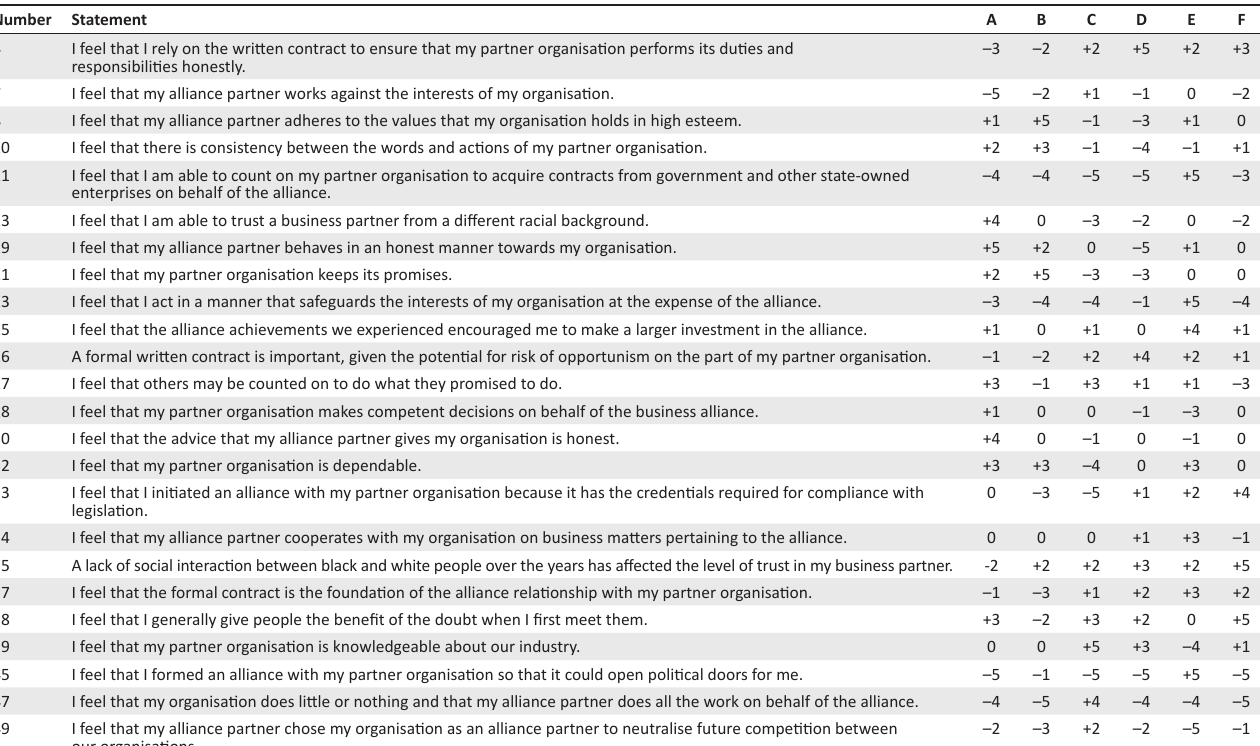
TABLE 1: Factor scores for six